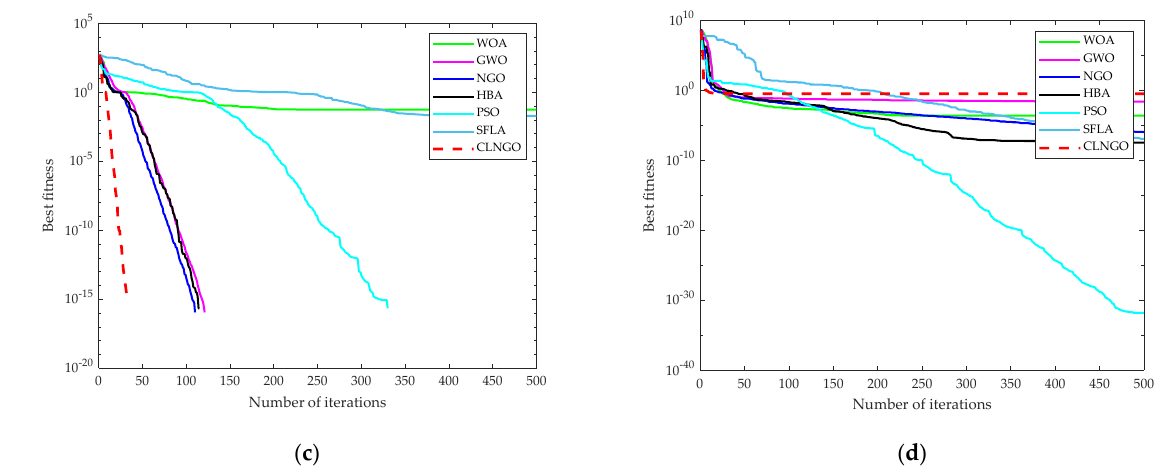
Figure 3. Convergence curve of the high-dimensional multi-objective function. ( a ) The convergence curve of function f5. ( b ) The convergence curve of function f6. ( c ) The convergence curve of function f7. ( d ) The convergence curve of function f8.